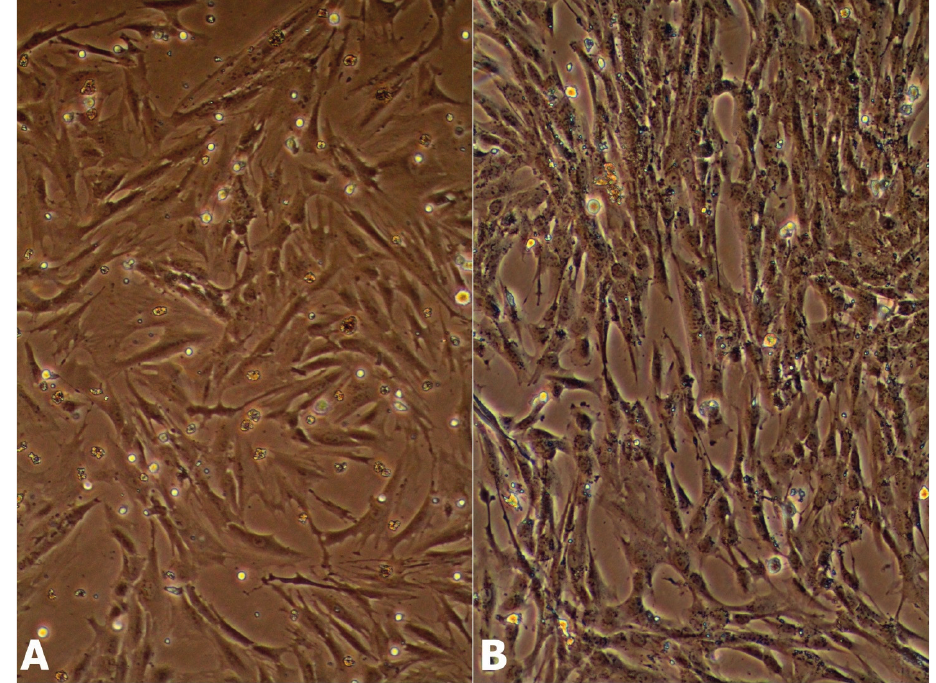
Fig. 1. Primary cell line of colorectal carcinoma derived from the tumour in gut (A) and its respec- tive lymph node metastasis (B) (200x, phase